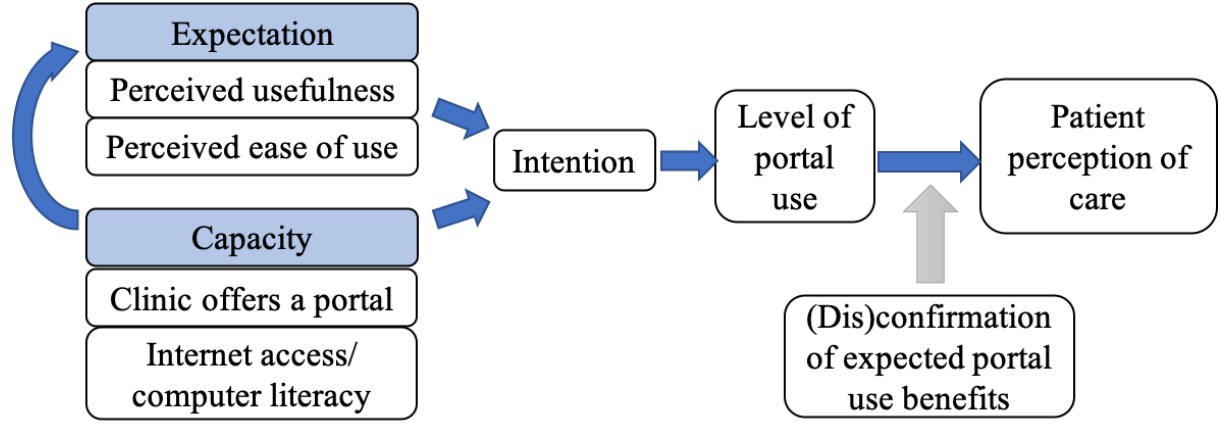
Figure 1. Integrated conceptual model of portal use and perception of care quality modified by expectation